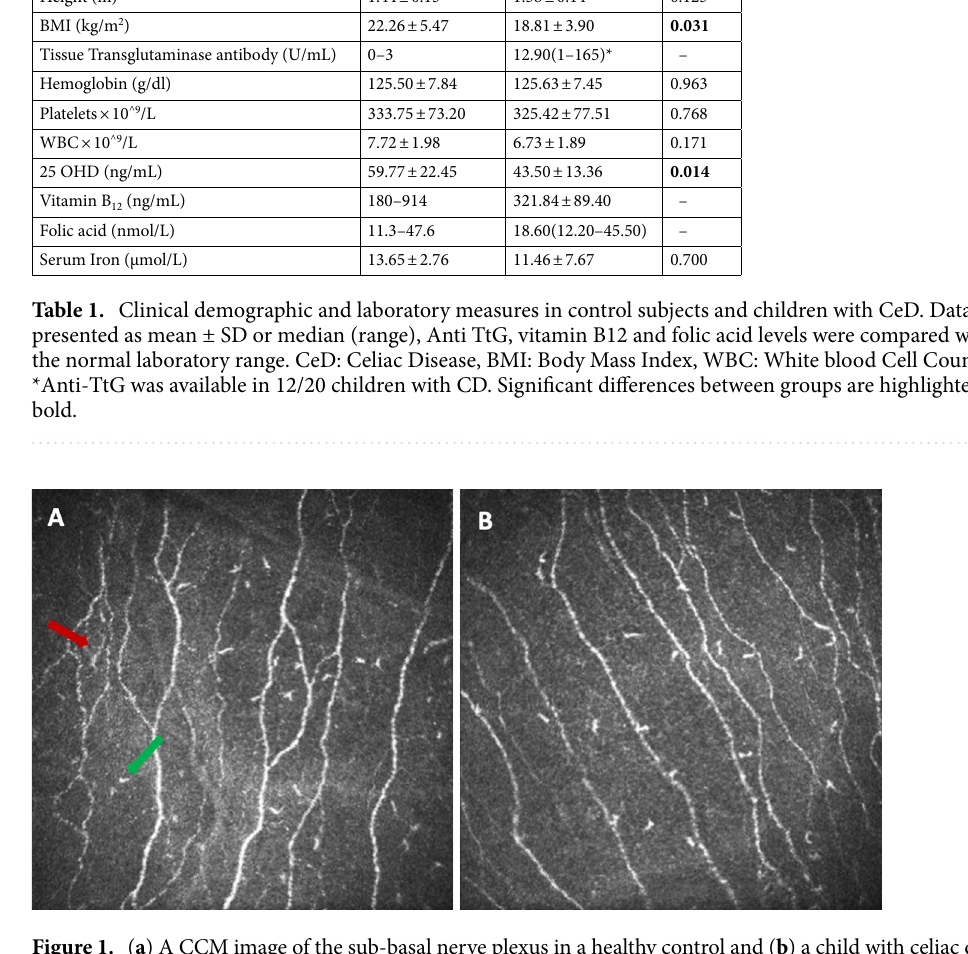
Density (no./mm 2